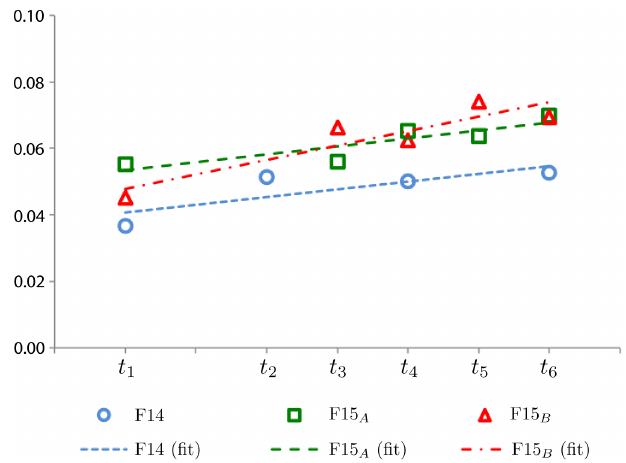
FIG. 5. The changes in network density for each section as a function of time. The x axis is rescaled to account for the adjustment on the data collection schedule. The solid lines represent a line of best fit for each section ( R 2 R 2 ¼ 0 . 76 , R 2 ¼ 0 . F 15 A F 15 B